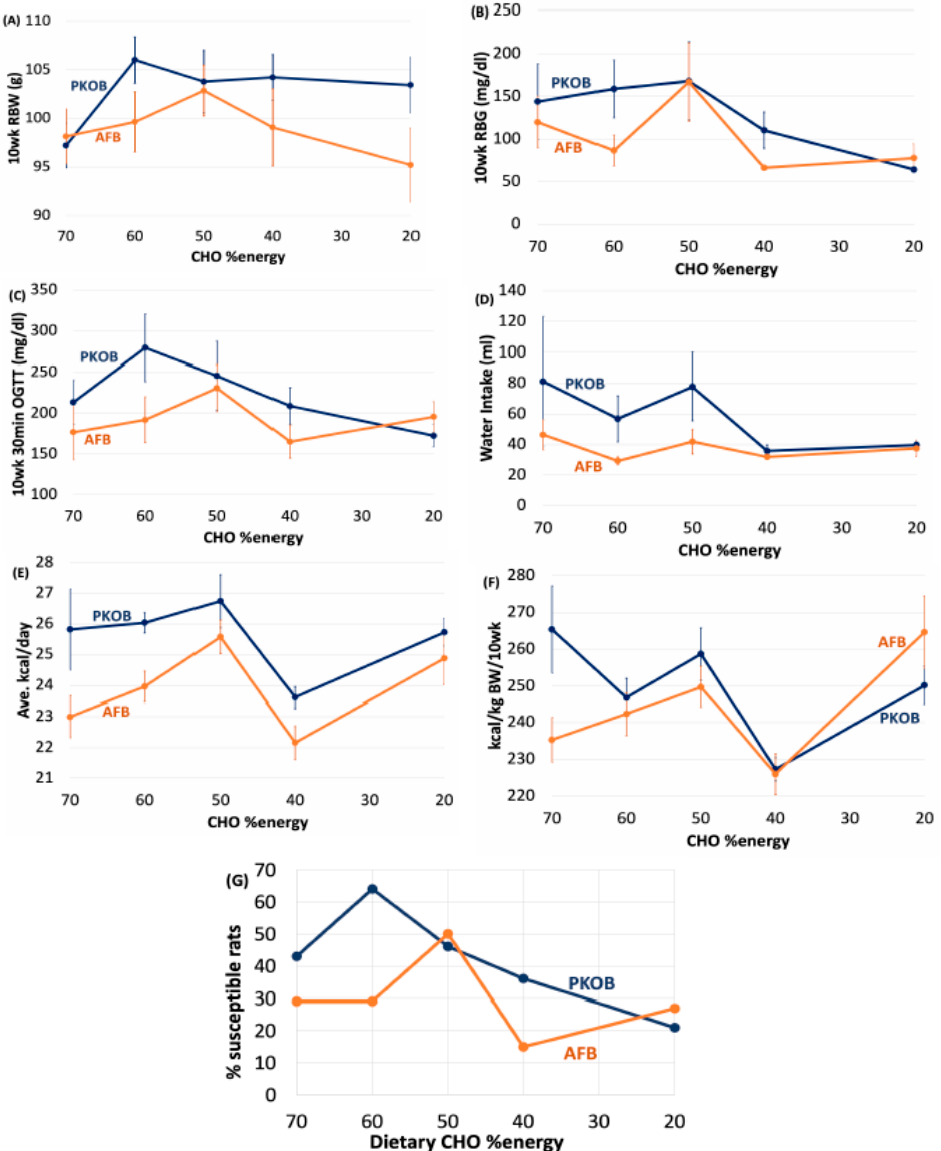
Figure 1. Clinical results for diabetes induction are depicted for all Nile rats ( n = 14 rats per CHO:fat ratio) based on the dietary CHO %energy designated on the X-axis starting at 70, 60, 50, 40, and 20% energy with corresponding fat increments at 10, 20, 30, 40 and 60% fat energy, respectively, for PKOB (blue) and AFB (orange). ( A ) PKOB tended to produce greater RBWs than AFB. ( B ) RBG revealed more diabetes with PKOB, i.e., 42% of rats for PKOB vs. 29% for the AFB. ( C ) The 30 ′ OGTT confirmed that diabetes was more severe with PKOB than AFB, especially at the two highest intakes of CHO. ( D ) Water consumption was greater for rats fed PKOB than AFB, but only for the 3 highest intakes of CHO at 70, 60, and 50% energy linked to diabetes severity. ( E ) Kcal/day was generally higher for PKOB and significant at 70 and 60 CHO %energy. ( F ) Once adjusted for BW, kcal/day was similar for all CHO intakes for both fats, except for 70% energy from CHO, where PKOB was greater than AFB. ( G ) PKOB induced a greater percentage of susceptible rats at 70, 60, and 40 CHO %energy, reflecting the greater extent of diabetes for PKOB (45% more) than AFB in general, as depicted in ( B ) above. The AFB with 50% energy from CHO also induced unique peaks in terms of RBG and %susceptible rats. In summary, these clinical data indicate that PKOB rats weighed more, consumed more calories and drank more water, with the most diabetes. This occurred at the 3 greatest hiCHO intakes for both fat types (see Tables S3 and S4 for details).